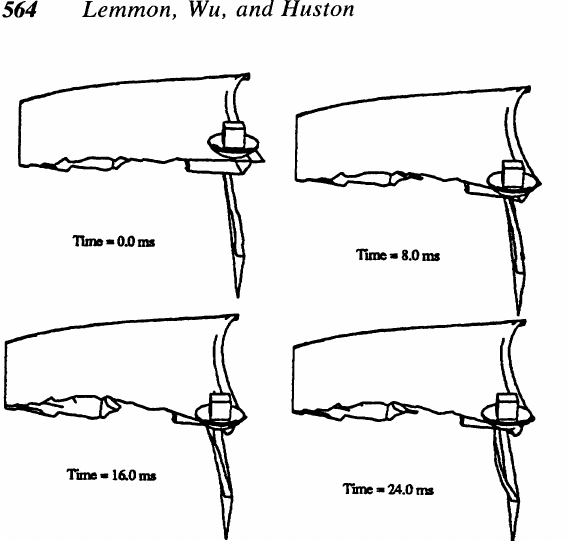
FIGURE 11 Baseline Taurus hood model: deforma tions. (Hood is cut away to reveal fire wall.)